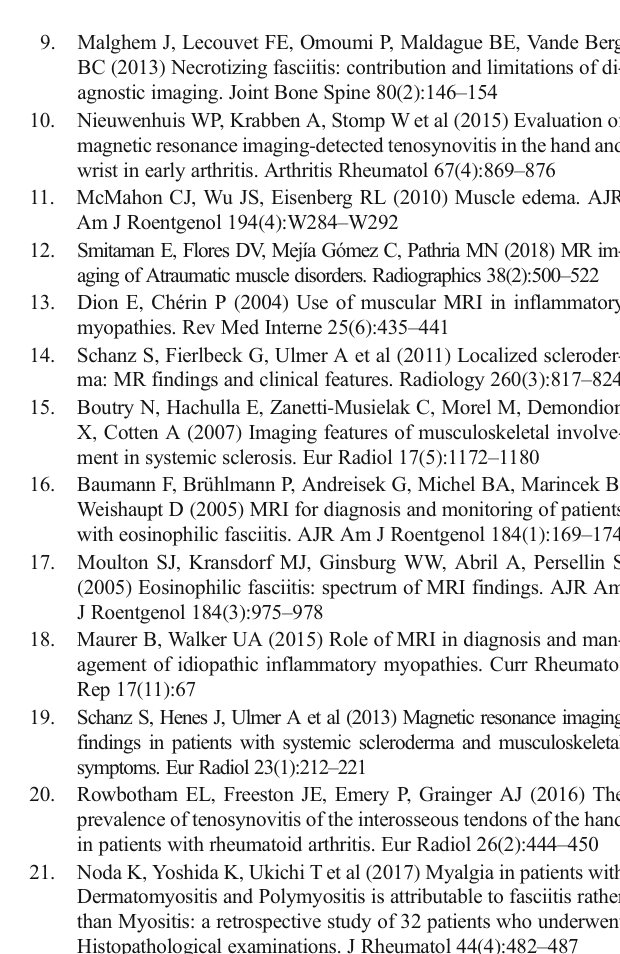
Fig. 21 Contrast-enhanced fat- suppressed T1-weighted ( a ) axial image of the hands and ( b ) coro- nal reformat of the left hand of a 30-year-old female with seropos- itive non-erosive rheumatoid ar- thritis. MRI demonstrates inflam- matory changes of the distal myo- tendinous junctions of the first dorsal interosseous muscles (ar- rows). Lack of synovitis suggests primary inflammatory involve- ment of the myo-tendinous junc- tion. Tenosynovitis of the flexor digitorum tendons is also seen